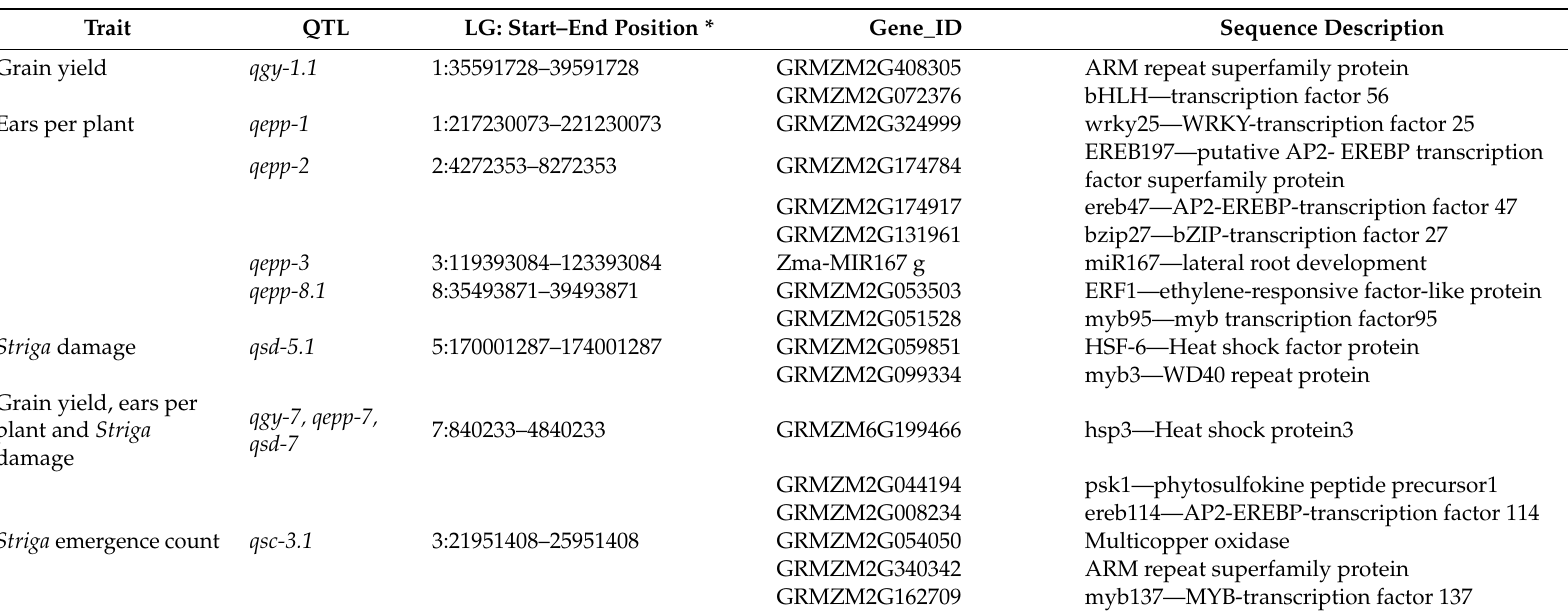
Table 4. Key putative candidate genes associated with the identified QTLs for key Striga resistance / tolerance indicator traits under artificial Striga infested